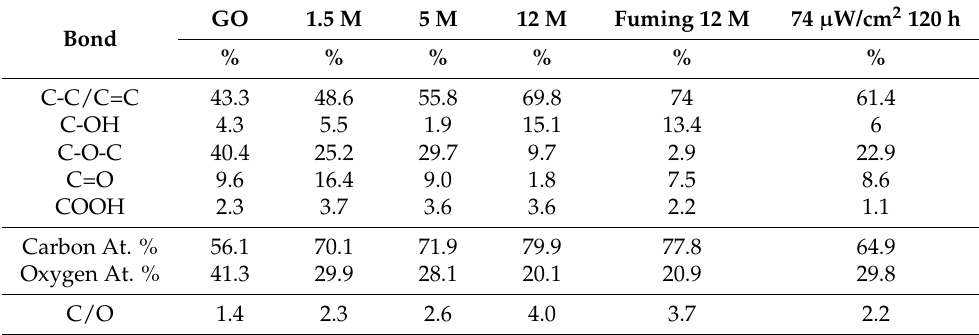
Table 1. Quantification of functional groups in as-produced GO and RGO with H 2 SO 4 and fuming H 2 SO 4 by